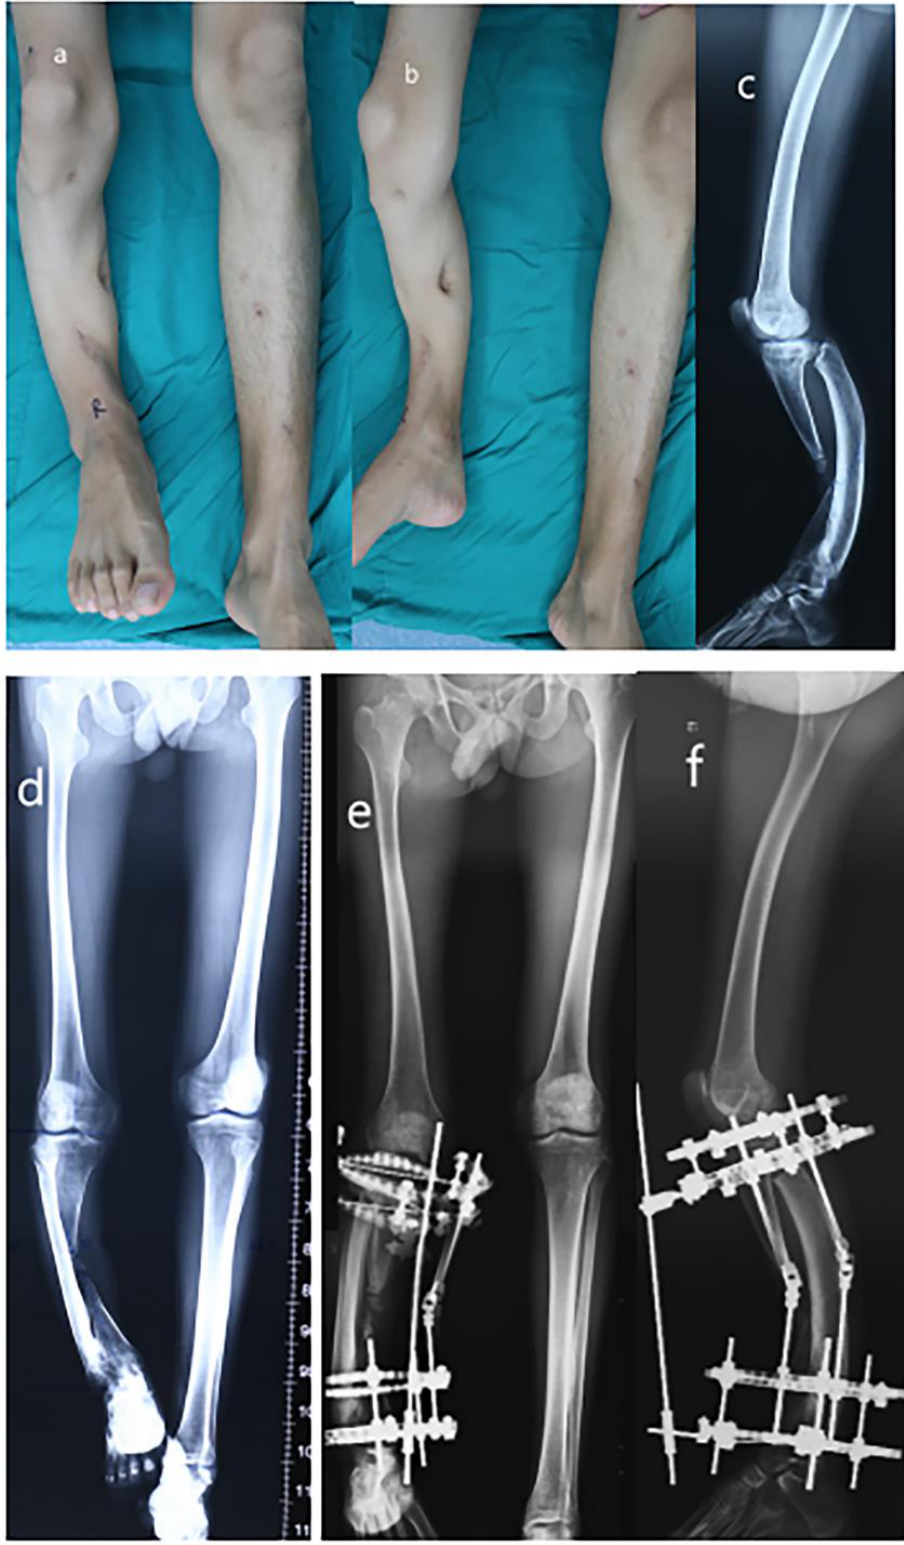
Figure 1. Radiograph of a 24-year-old male of severe limb length discrepancy and tibia varus. ( a ) Appearance (AP view); ( b ) Appearance (lateral view); ( c ) Preoperative later view radiograph; ( d ) Preoperative AP view radiograph; ( e ) Postoperative AP view radiograph; ( f ) Postoperative lateral view radiograph.